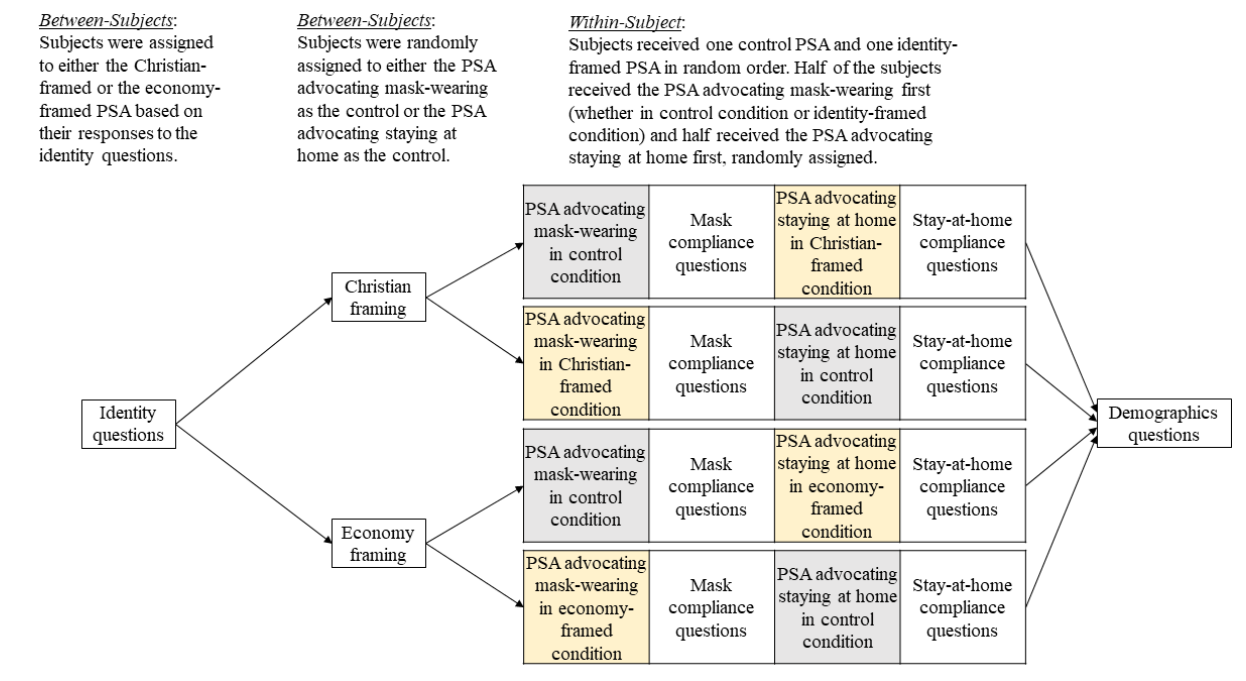
Figure 1. Experimental design. PSA: public service